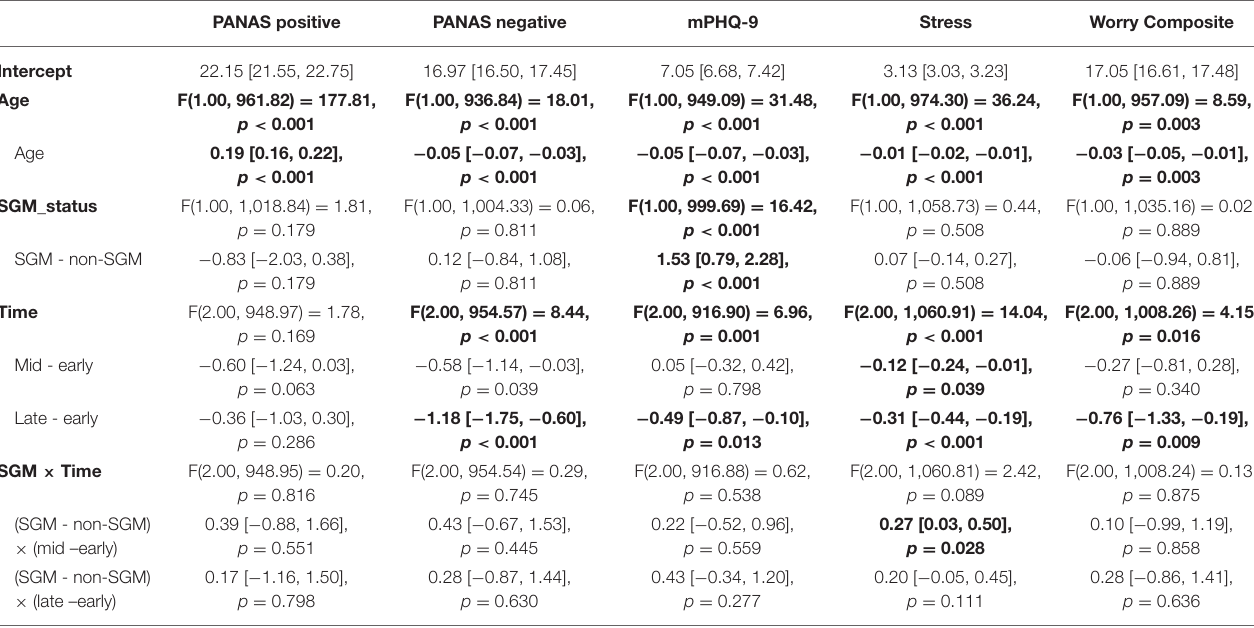
TABLE 2 | Model 1 regression results.